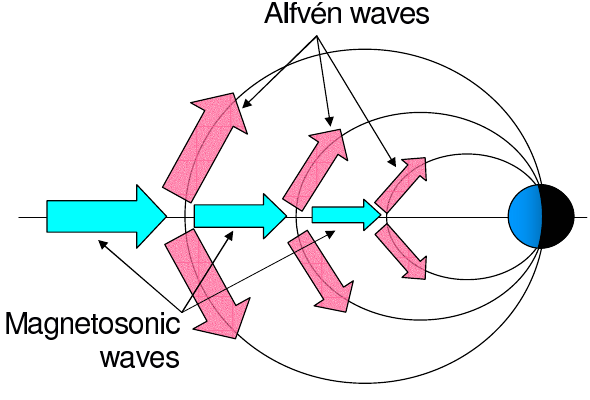
Fig. 8. Schematic of possible Pc3–4 energy propagation to the high- latitude ionosphere.